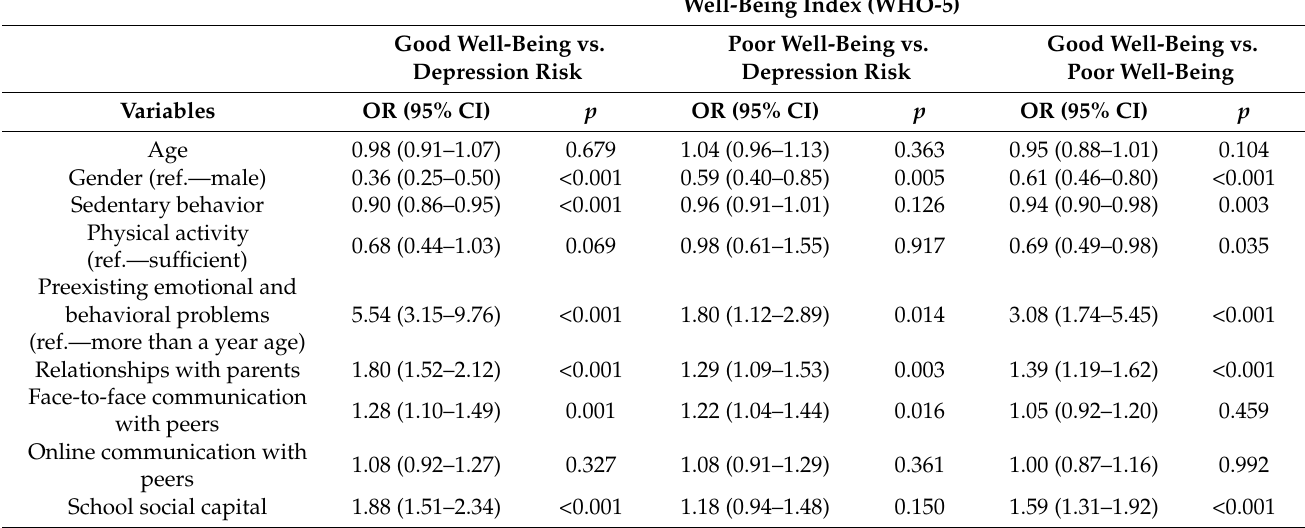
Good Well-Being